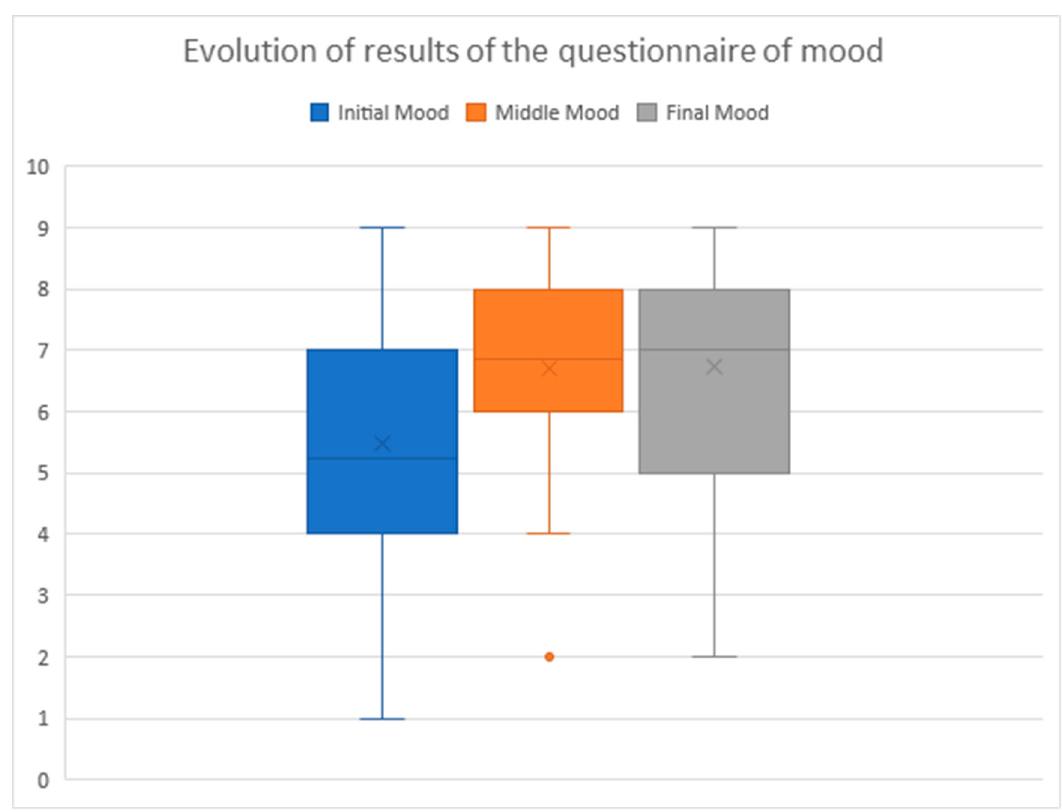
Figure 2. Data representation of the initial, middle, and final mood ( n =